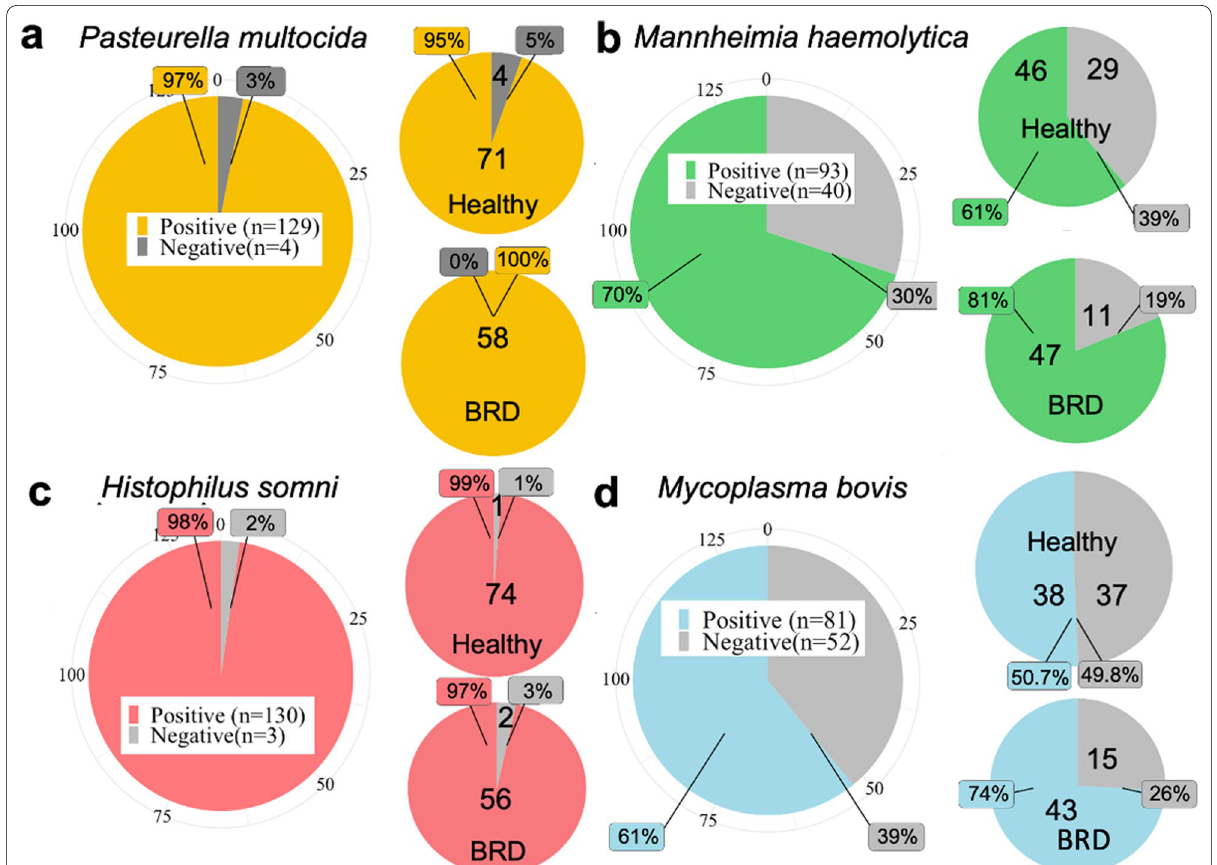
133) and between healthy (n 75) and BRD (n 58) Holstein = = =